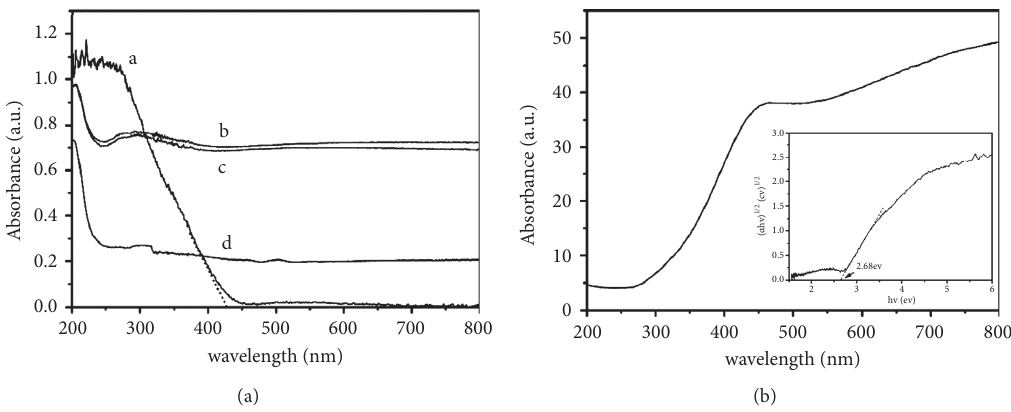
Figure 6: (a) UV-vis light adsorption of the different composites: (A) AgSb 500; (b) UV-vis DRS and bandgaps calculation diagram of AgSb 2 O 5.8